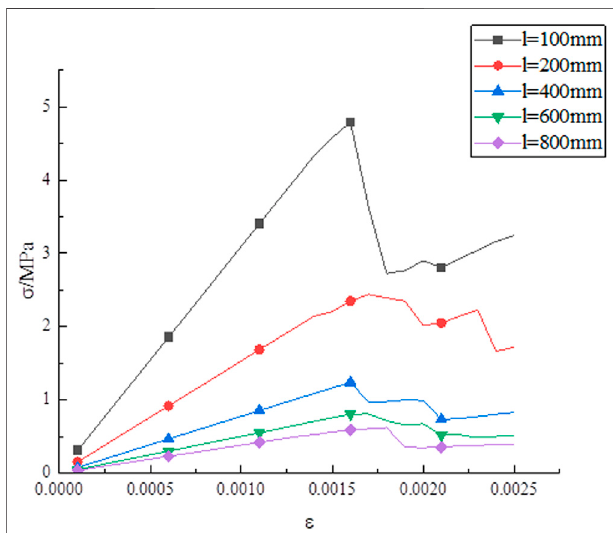
FIGURE 8 | The stress-strain curve of different rock